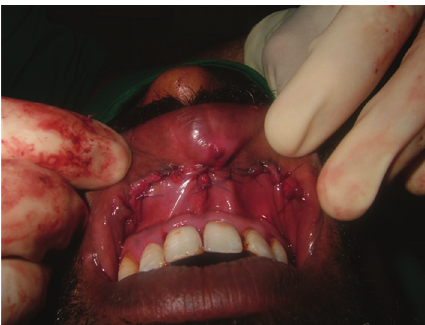
Figure 3: Dissection of hyperplastic upper labial tissues. Figure 4: Sutures